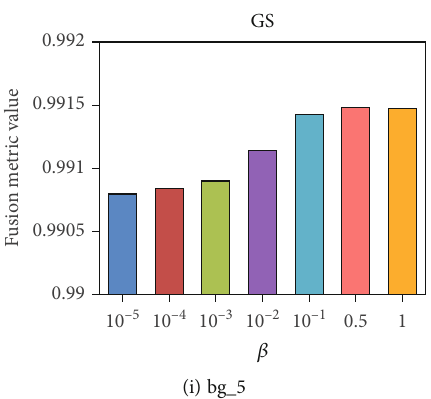
Figure 6: Performance of proposed method with di ff erent settings of parameter β for di ff erent